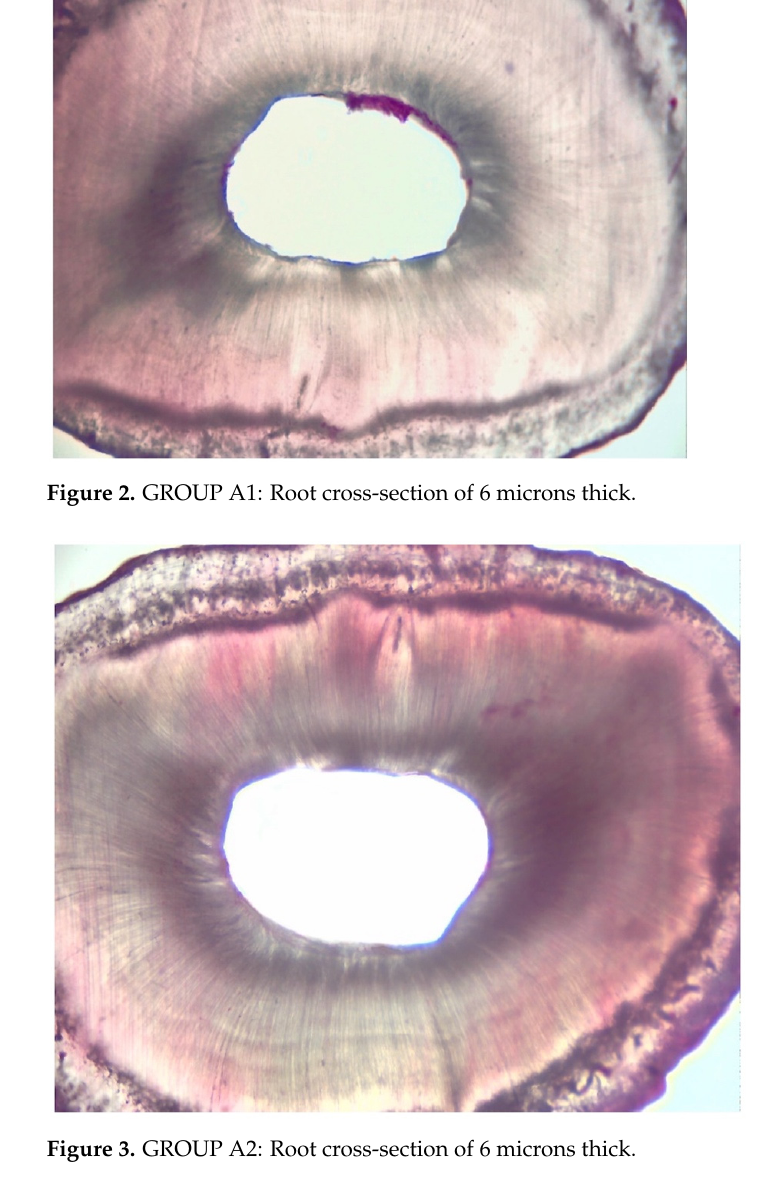
Figure 3. GROUP A2: Root cross ‐ section of 6 microns thick.